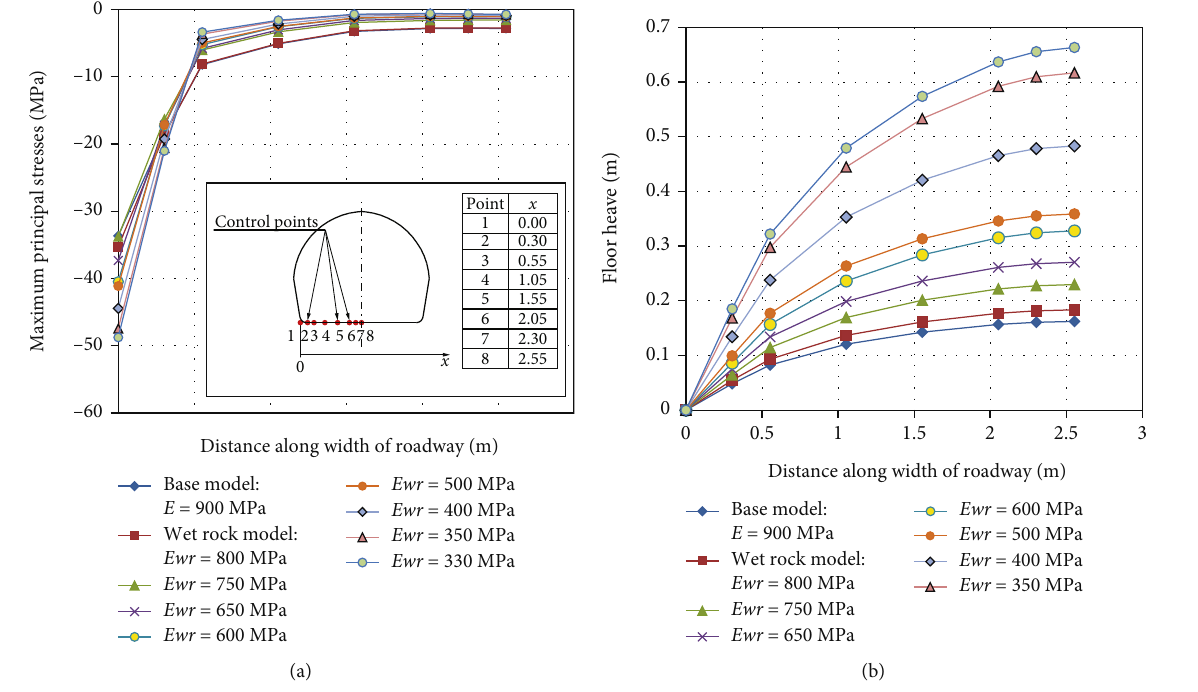
σ wr ) on the maximum ( 1 ) principal stresses (a) and roadway